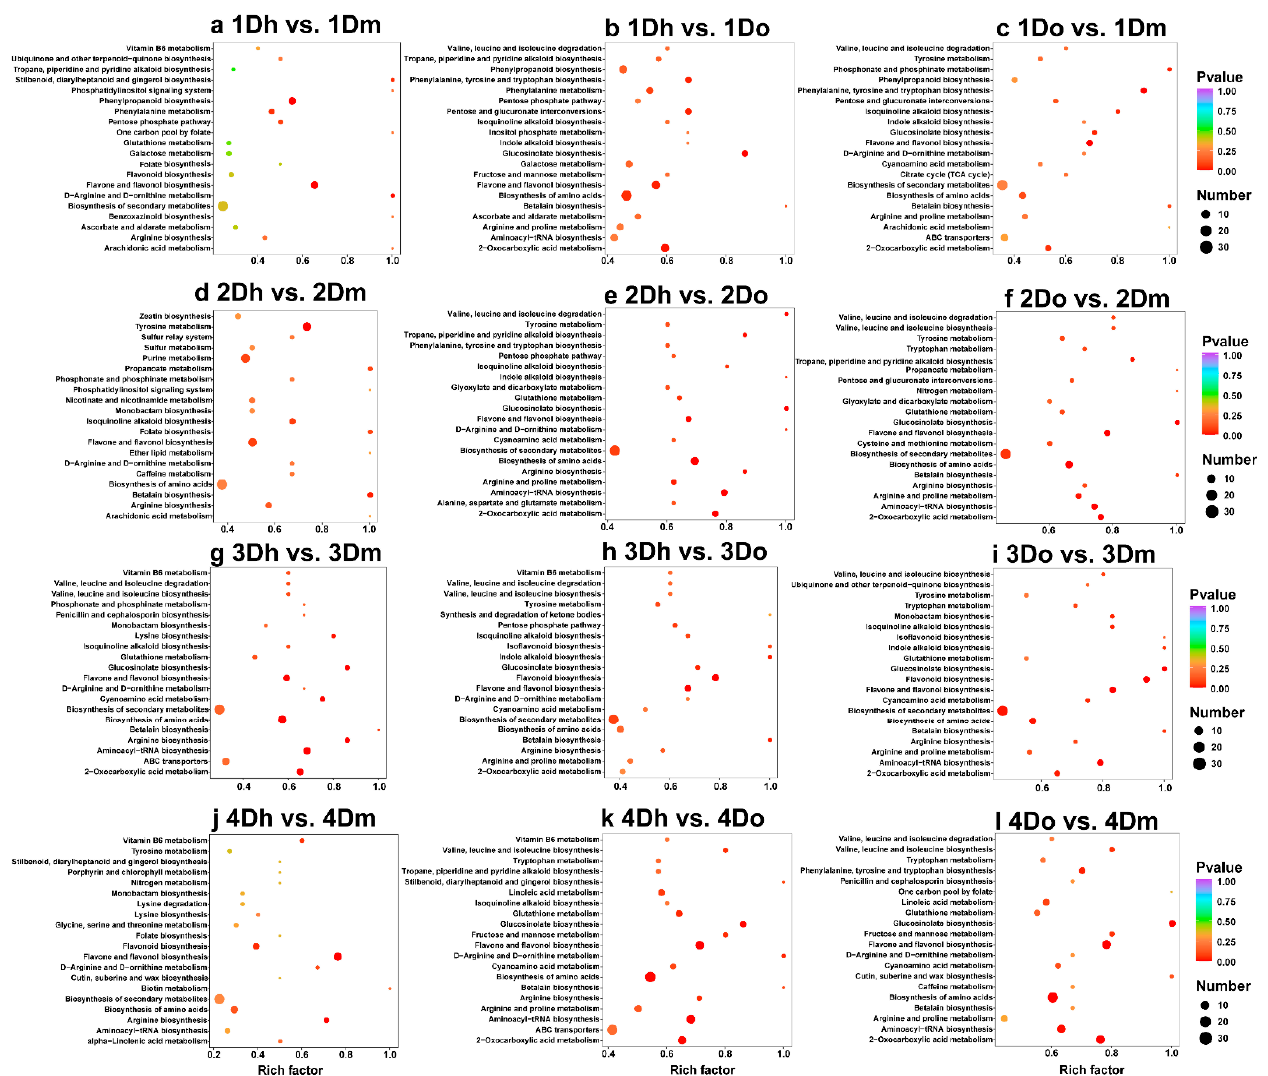
Figure 3. KEGG enrichment analysis of DAMs. The X-axis label represents the rich factor, and the Y-axis label shows the KEGG pathways. Colors indicate p -values (from the lowest in red to the highest in blue), red indicates significant enrichment ( p < 0.05), and green indicates not significantly enriched. The size of the bubbles represents the number of DAMs. The rich factor represents the ratio of the number of DAMs in each pathway to the total metabolites, and the larger the rich factor, the higher the enrichment of the pathway.